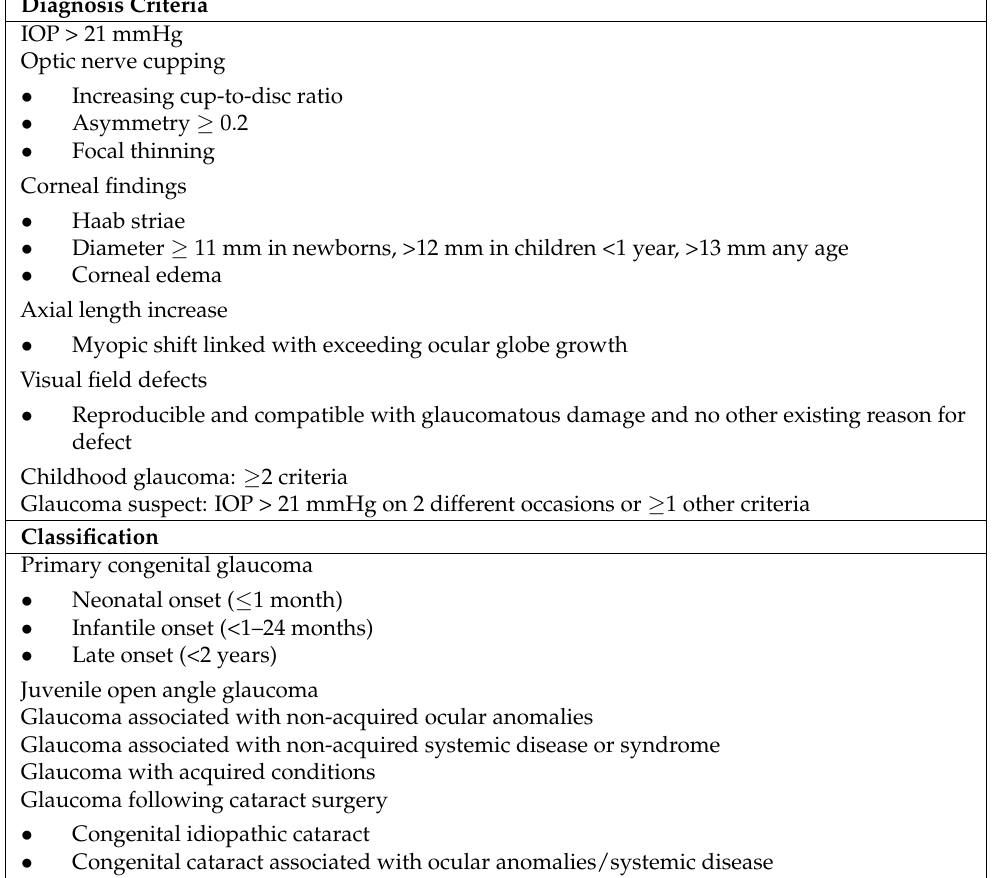
Table 1. Childhood Glaucoma Research Network (CGRN) diagnosis criteria and classification